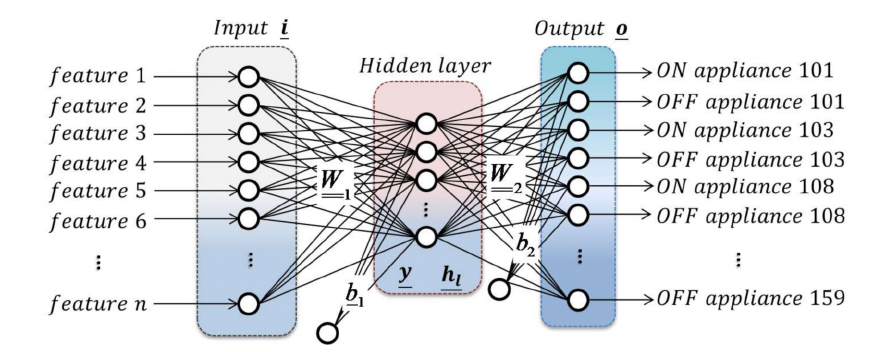
Figure 2. The MLP